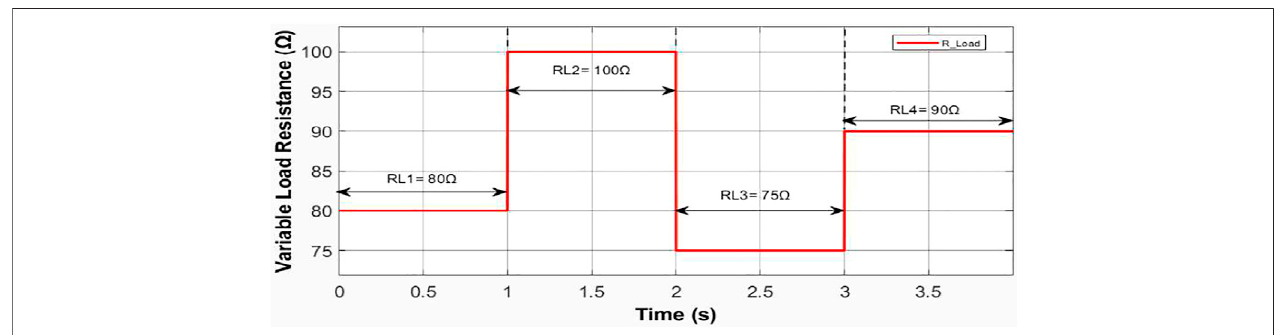
FIGURE 11 | Load variations pattern for